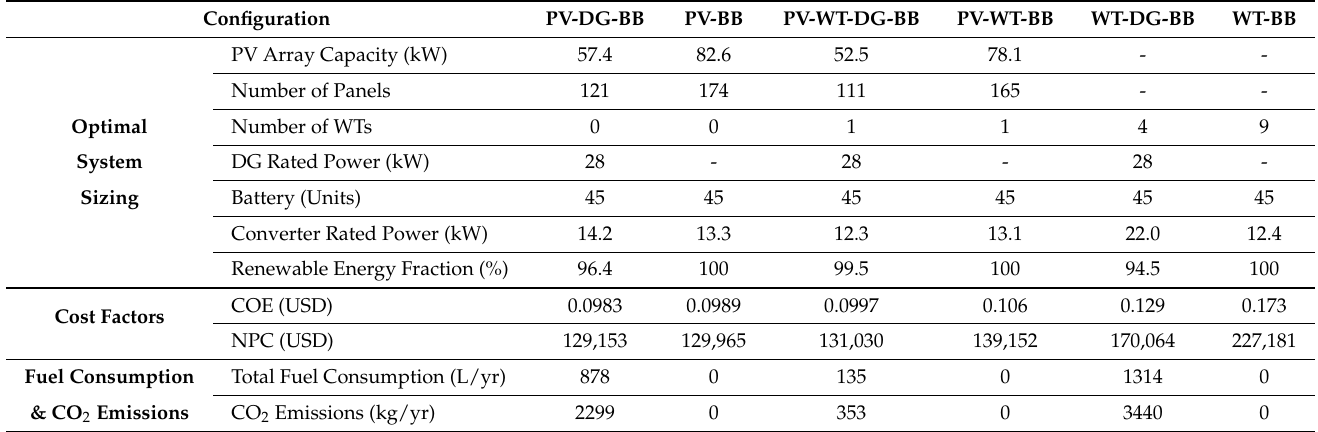
Table 16. Simulation Results for Wafra Cell Site—Case